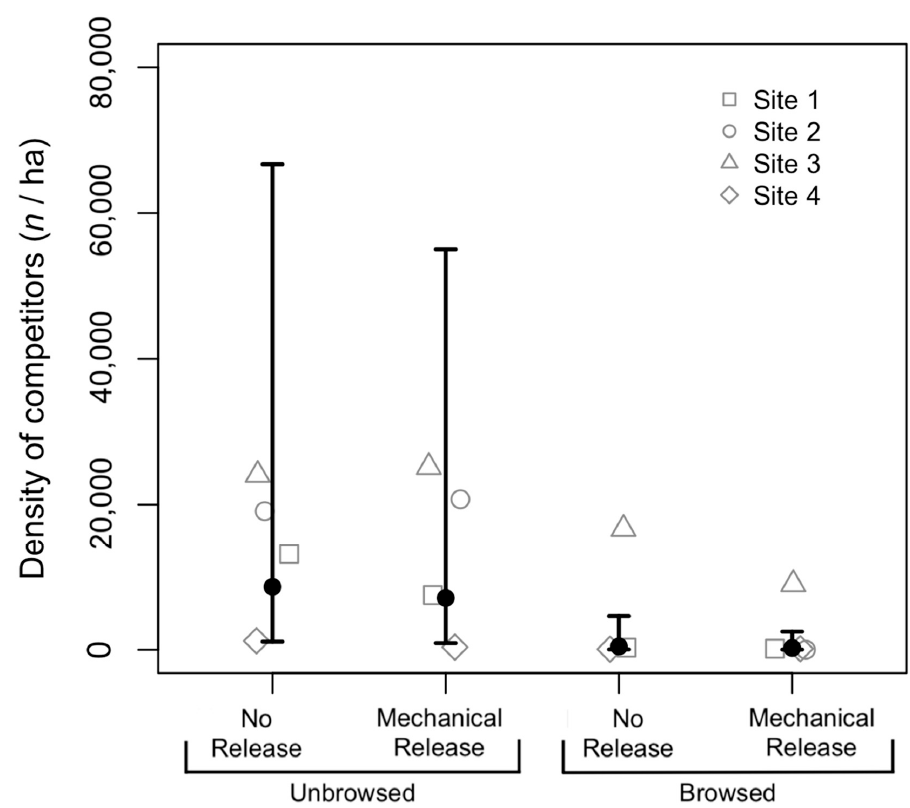
Figure 1. Density of the competing tree saplings in four white spruce plantations receiving combinations of browsing exclusion (unbrowsed or browsed) and forest cleaning (no release or mechanical release) treatments. Predicted values were estimated from a generalized linear mixed model with a negative binomial distribution and with the forest cleaning treatment nested within the browsing exclusion treatment, nested within the site, as a random factor. Error bars are 95% confidence intervals. Raw averages are shown in gray. Both the browsing exclusion and the forest cleaning treatments significantly lowered the competitors’ density. Although their interactive effect was not statistically significant, the present figure gives a better picture of their relatives effects.